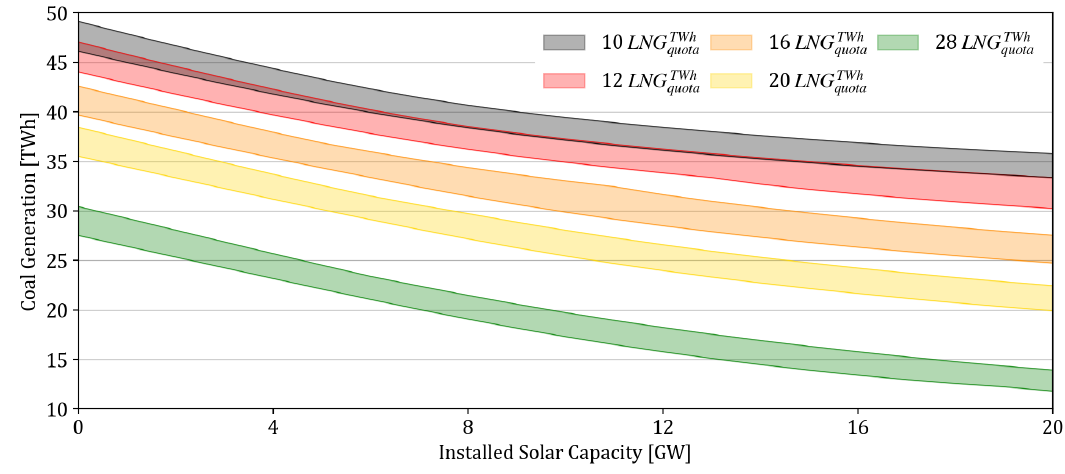
Figure 13. The coal generation in different LNG quota scenarios.